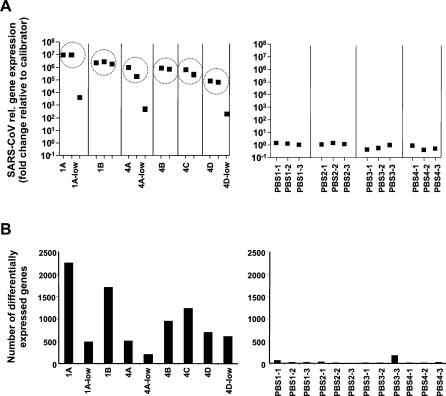
SARS-CoV mRNA Levels and Global Gene Expression in Lungs of SARS-CoV–Infected Macaques(A) RT-PCR was performed on all individual pulmonary samples from SARS-CoV–infected animals and mock-infected animals to determine SARS-CoV levels. Samples from SARS-CoV–infected animals that were pooled for microarray studies are indicated with circles. The three samples with lower levels of virus were hybridized separately. The 12 samples from mock-infected animals (i.e., PBS) were pooled and served as a reference sample. The number after PBS refers to the animal (i.e., PBS 1), while the number after the dash refers to the lung piece (i.e., PBS 1-1).(B) Using microarrays, gene expression in SARS-CoV–infected animals was compared to gene expression in mock-infected animals. The bar graph shows the total number of genes considered to be differentially expressed, defined as an absolute fold change > 2 with p < 0.0001. Samples 1A and 1B (day 1) and 4A–4D (day 4) are composed of the pooled individual pulmonary samples shown in (A). Samples 1A low, 4A low, and 4B low are the outliers from (A). Separate mock samples (i.e., PBS) were compared to the total mock pool.